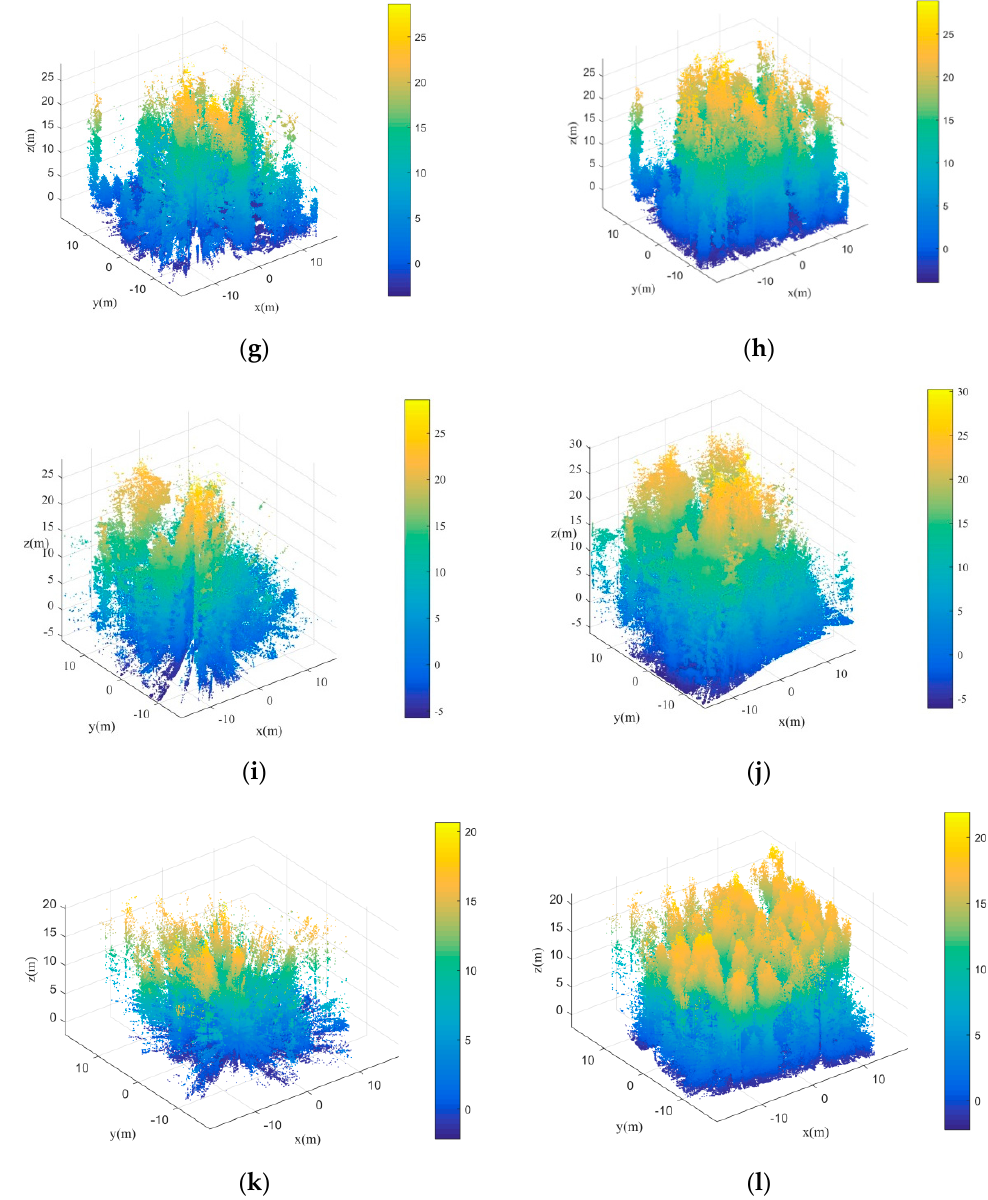
Figure 10. Point clouds of six plots. ( a , b ) are point clouds of Plot 1; ( c , d ) are point clouds of Plot 2; ( e , f ) are point clouds of Plot 3; ( g , h ) are point clouds of Plot 4; ( i , j ) are point clouds of Plot 5; ( k , l ) are point clouds of Plot 6. The first column represents point clouds scanned in the single-scan mode, while the second column represents point clouds scanned in the multi-scan mode.